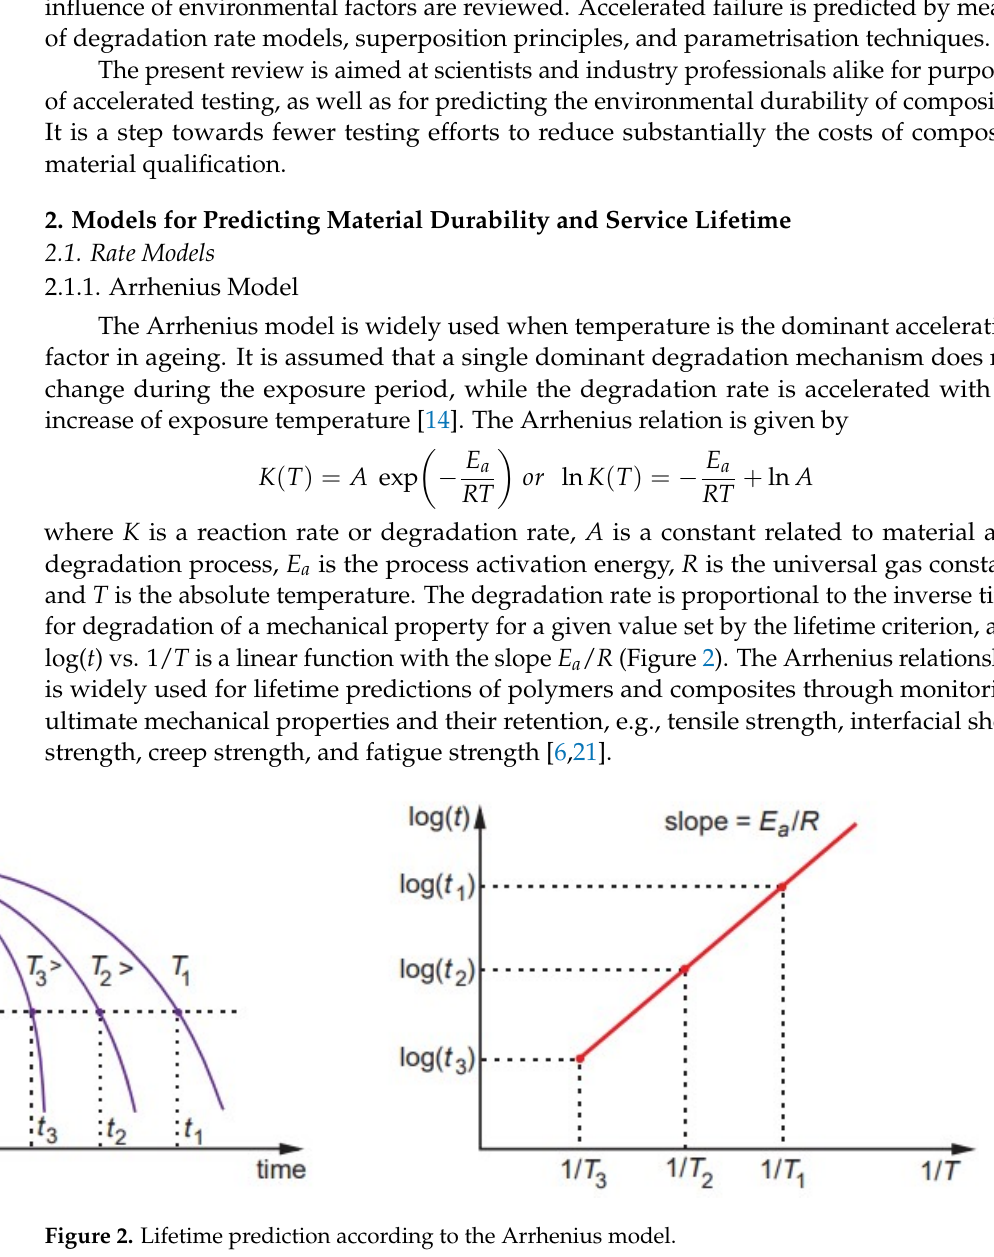
Figure 2. Lifetime prediction according to the Arrhenius model.